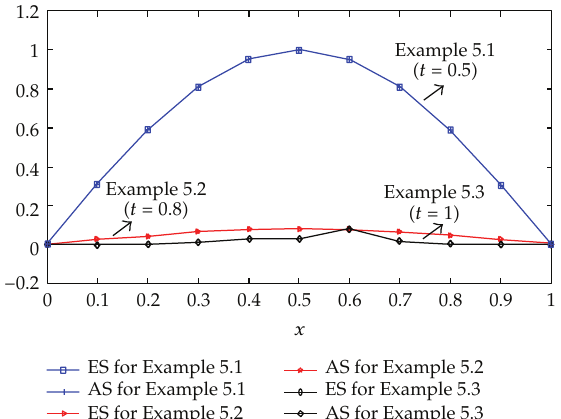
Figure 10: The compared results of the analytical and numerical solutions of Examples